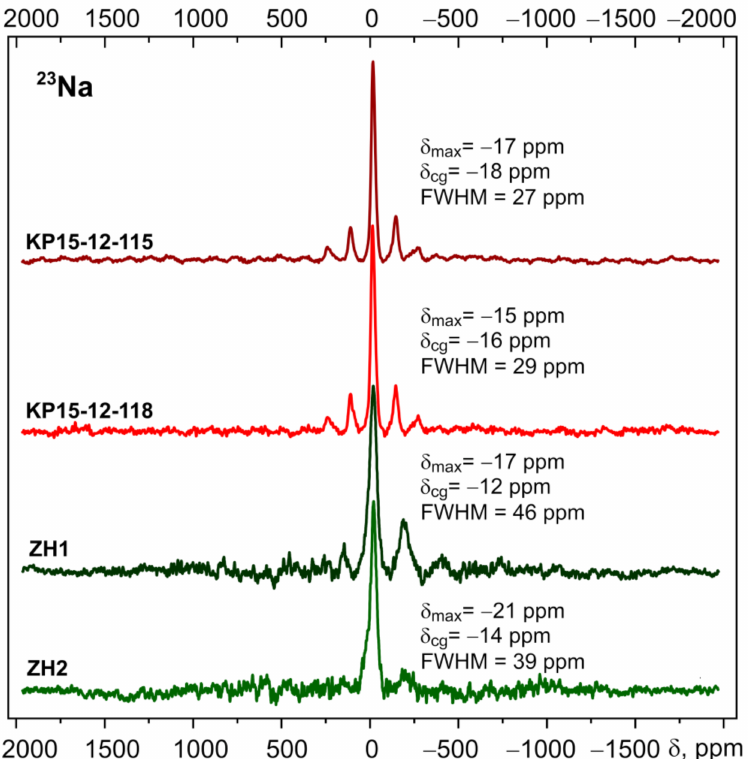
Figure 3. Overview 23 Na MAS NMR spectra of the impact glasses. The positions of the maxima and the centers of gravity of the central bands, as well as their FWHM values, are